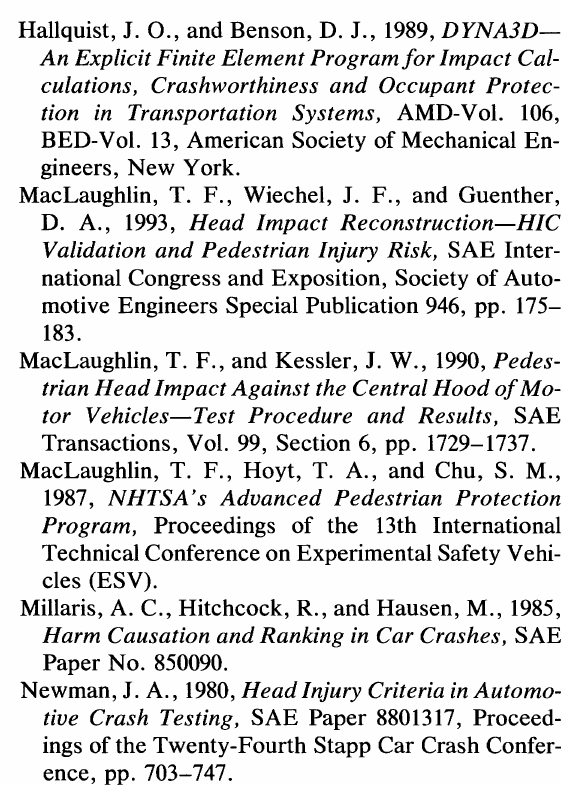
FIGURE 21 Spline curve fit of HIC versus fender material